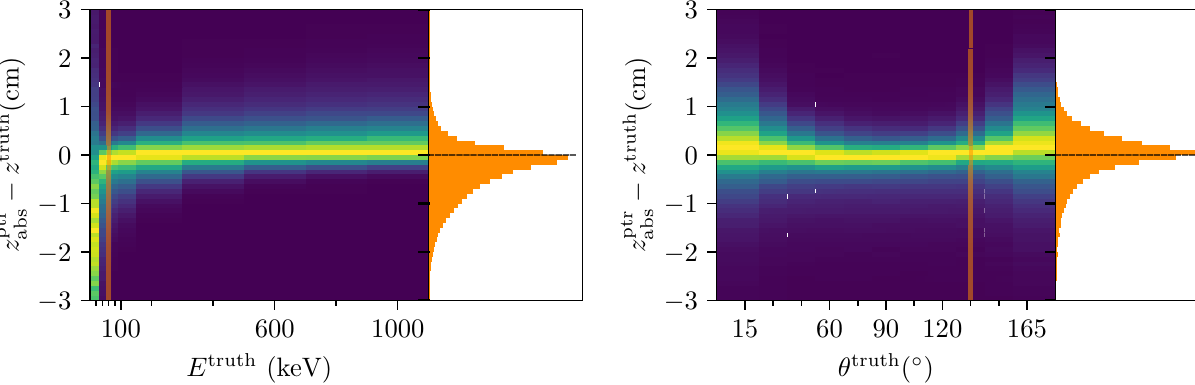
Fig. 11 The absolute error in the absolute position z ptr tion versus primary track energy (left) and polar angle (right). The color/shade indicates the number of events in 2D bins, independently